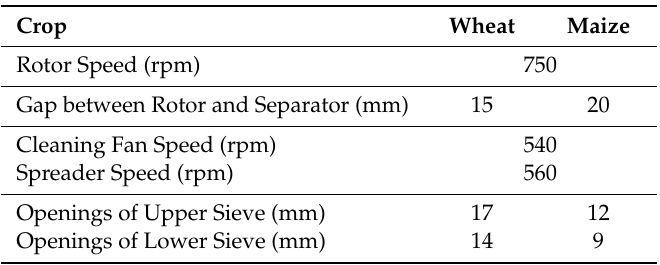
Table 1. Axial Flow combine harvester (CASE IH Axial Flow 7088, Racine, WI, USA) settings used during harvesting of maize and wheat. Crop Wheat Maize